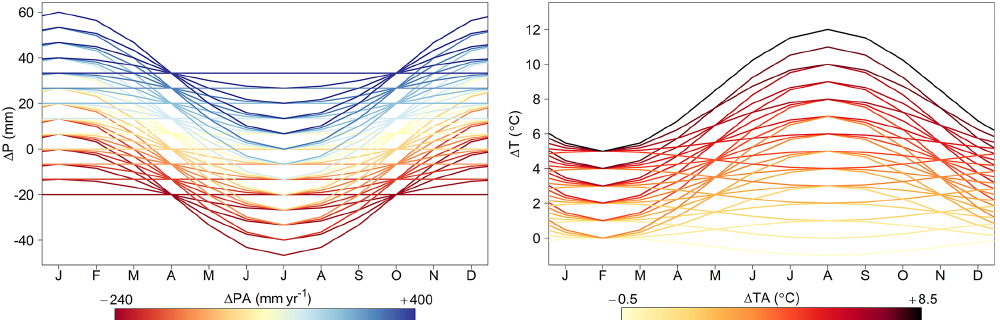
Figure 8. Monthly perturbation factors (cid:49)P and (cid:49)T associated with the climate sensitivity domain. The colour of the line is related to the intensity of the annual change (cid:49)PA and (cid:49)T A